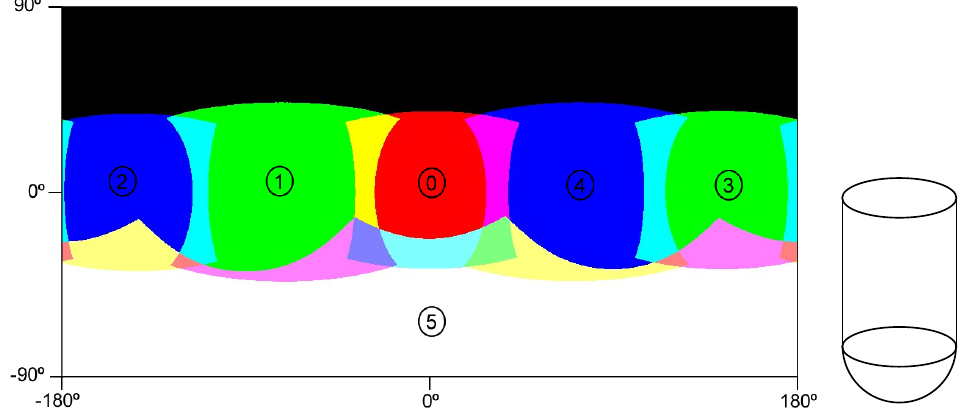
Figure 6. Equirectangular projection of the covered FOV at a 5-m distance with a hemispherical interface for the bottom camera and 2.95-mm focal length optics for Cameras 1, 4 and 5. Each colored region represents the FOV of each camera (red, green, blue and white) and the areas of FOV intersection (other colors).